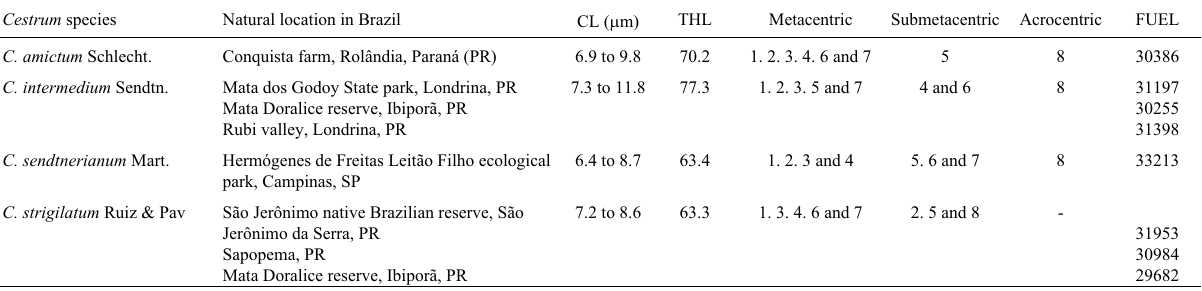
Table 1 - Chromosome measurements and morphology of the Cestrum species and populations analyzed. CL = Length of large and small chromosome pairs; THL = Total length of haploid set. Cestrum species Natural location in